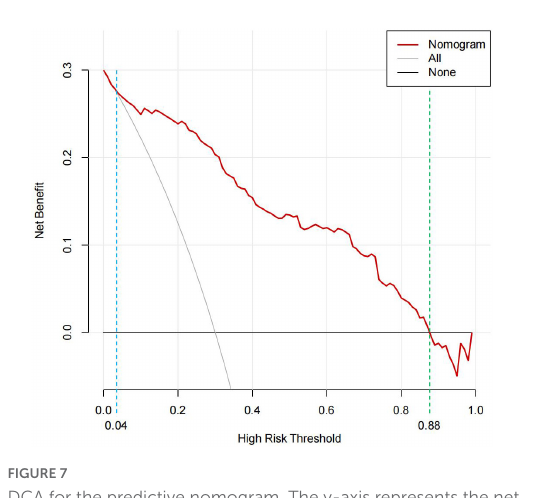
FIGURE5 ROC curve for evaluating the model’s discrimination performance. AUC of the ROC curve is 0.894 (95% CI, 0.850–0.938). ROC, receiver operating characteristic; AUC, area under the curve.